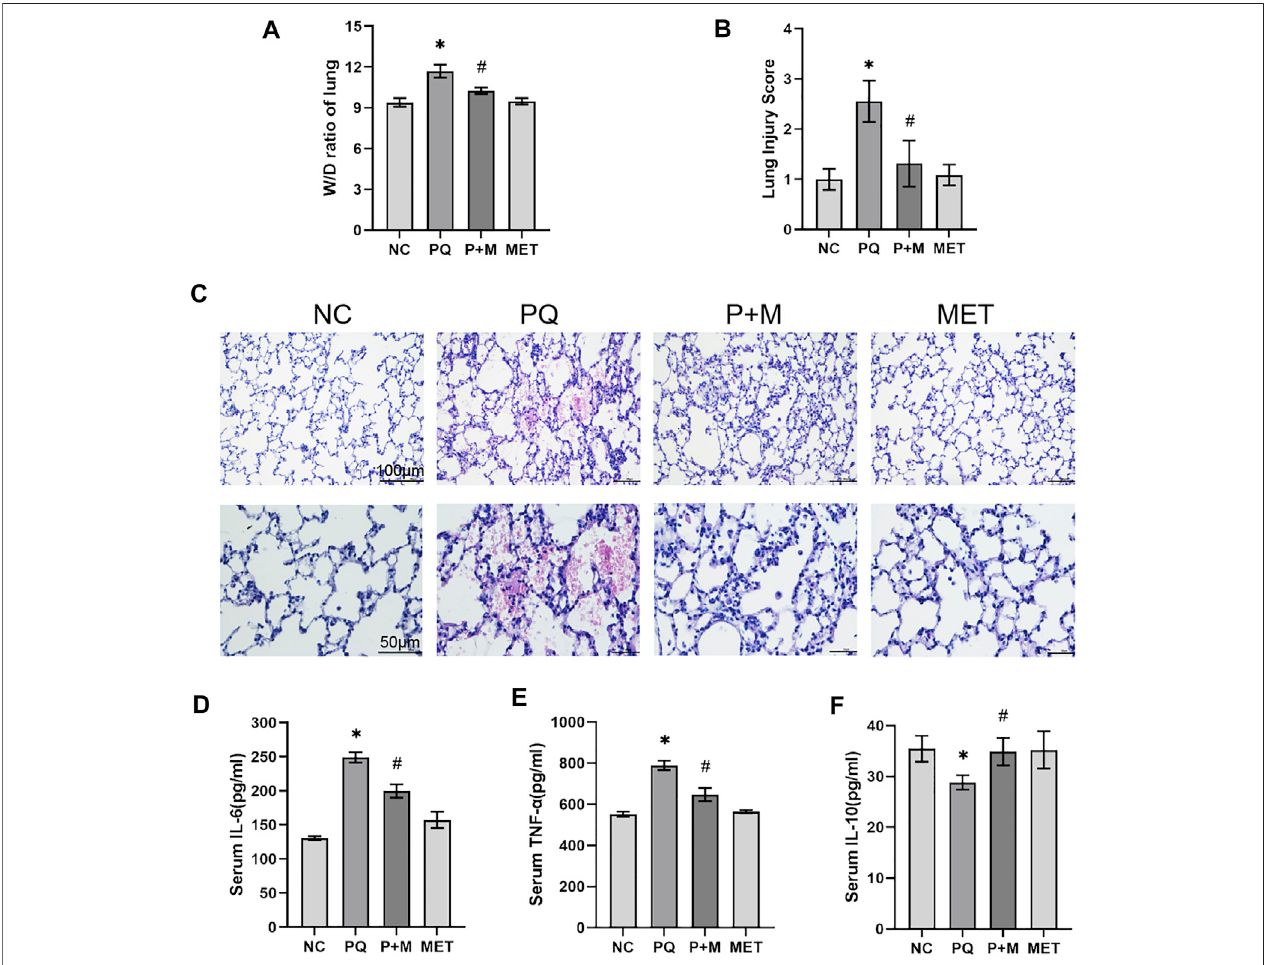
FIGURE 2 | The effect of MET on ALI and systemic in fl ammatory response in PQ-poisoned rats. (A) Lung W/D ratio, (B) Lung injury score, (C) Lung HE staining, ELISA kit to detect the levels of IL-6 (D) , TNF- α (E) , and IL-10 (F) in the serum of rats in each group ( n = 6). Compared with the NC group, * p < 0.05; compared with the PQ group, # p <